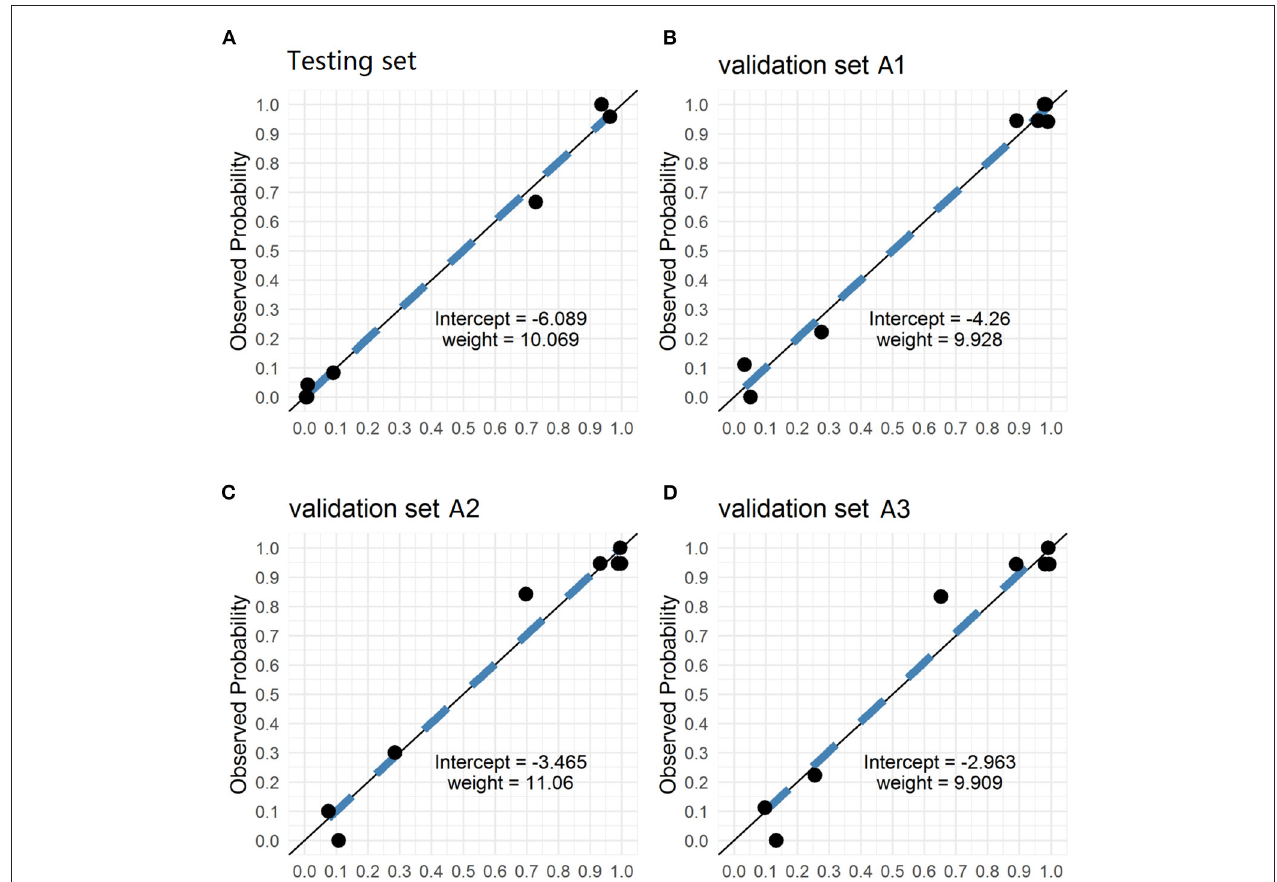
FIGURE 3 | The Calibration curves of testing and validation set A1 (Internal dataset), validation set A2 and A3 (external dataset). The calibration curves of the predicted probability from our PM-CAD vs. the observed probability for PM in (A) the testing set, (B) the validation set A1, (C) the validation set A2, and (D) the validation set A3. We used logistic regression to rebuild the prediction probability from our CNN model. The intercepts on the testing and verification set A are − 6.098, − 4.26, − 3.465, and − 2.963, respectively. And the probability weight W is 10.069, 9.928, 11.06, and 9.909, respectively. CNN, convolutional neural network; PM-CAD, Pituitary microadenoma-computer-aided